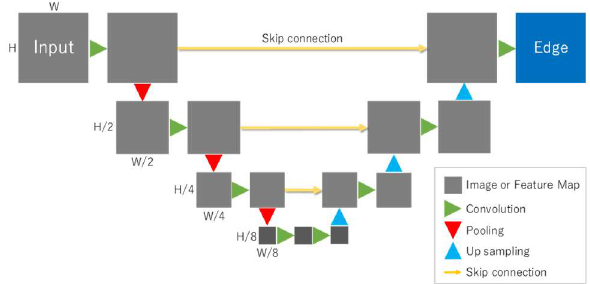
Figure 4. Diagram of the proposed